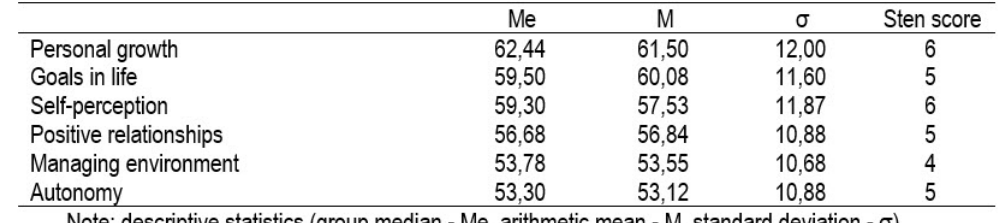
Descriptive statistics of evaluation of junior students’ characteristics of well-being according to K.Ryff’s “Scale of Psychological Well-being”